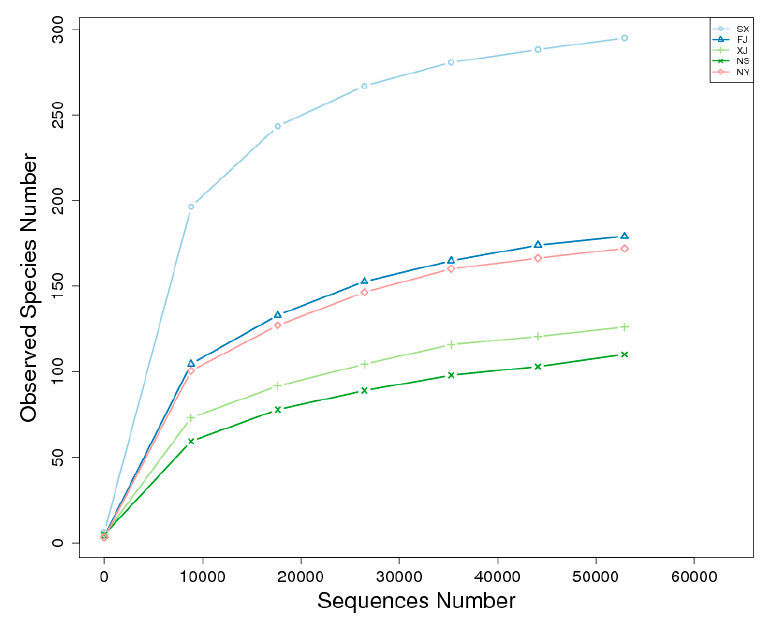
Figure 6. Rarefaction curves of bacterial community composition in five samples. Table 3. Median alpha diversity